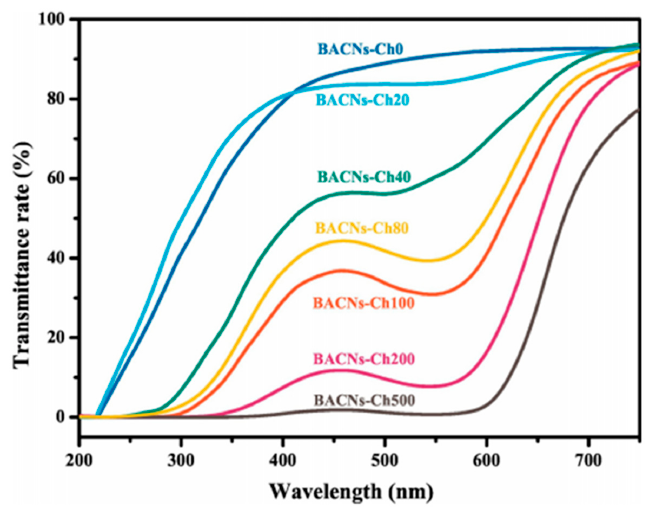
Figure25. LighttransmissionratesoftheBACNs-Chfilmscontainingdi ff Figure 25. Light transmission rates of the BACNs-Ch films containing different BACN concentration [97].